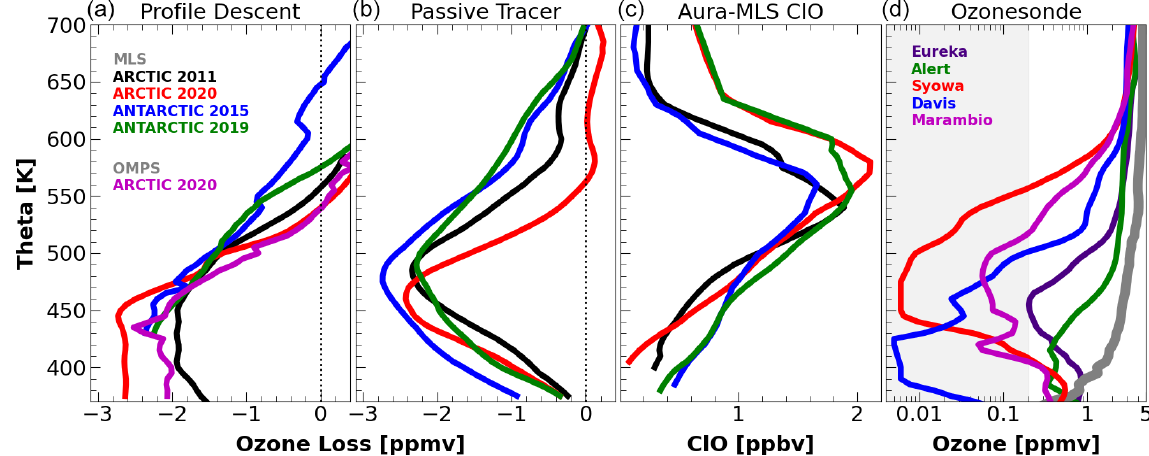
Figure 5. The Arctic and Antarctic ozone loss saturation and chlorine activation. (a) The ozone loss estimated using the Microwave Limb Sounder (MLS) measurements by applying the vortex descent method for the Arctic winter of 2019–2020 compared to the Arctic winter of 2011 and the Antarctic winters of 2015 and 2019. The ozone loss estimated with Ozone Mapping and Profiler Suite (OMPS) measurements is also shown. (b) The ozone loss estimated using the passive tracer method for the Arctic winter of 2020 and the Antarctic winters of 2015 and 2019. (c) The activated profiles ClO measured by MLS for the Arctic winters of 2011 and 2020 and the Antarctic winters of 2015 and 2019. The profiles are selected for the days with peak ClO values and are averaged for 3d. (d) Ozonesonde measurements from selected Antarctic and Arctic stations. The Antarctic ozonesonde measurements (Davis, Marambio, and Syowa) from past winters and the Arctic measurements (Alert and Eureka) from the Arctic winter of 2020. The grey colour represents an ozone profile without ozone depletion in the Arctic and Antarctic. The grey-shaded region represents the ozone loss saturation threshold. The dates of ozonesonde measurements are 8 April 2020 (Alert) and 10 April 2020